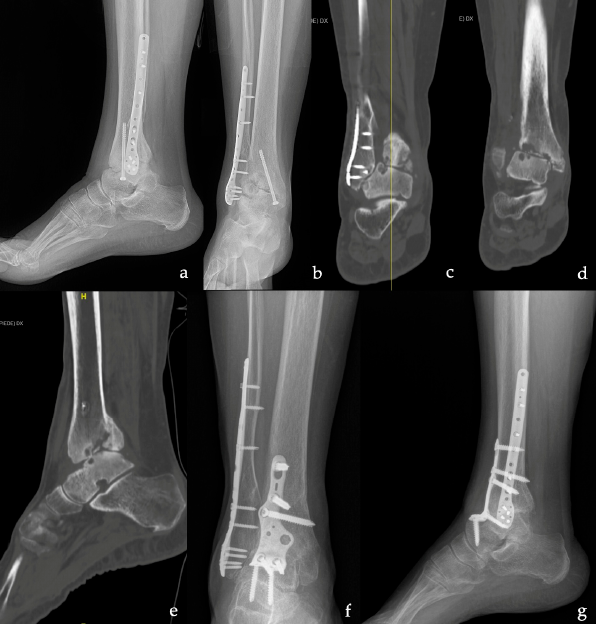
Figure 1. A 74-year-old woman with secondary post-traumatic TT osteoarthritis (OA). ( a - b ) Pre- operative X-ray in the lateral and anteroposterior view. ( c – d ) Coronal pre-operative CT scan showing severe OA of the TT joint. ( e ) Sagittal pre-operative CT scan at the level of the yellow line in figure c. ( f - g ) Anteroposterior and lateral X-ray at 6 months of follow-up from tibiotalar (TTC) arthrodesis with the anterior plate showing complete bone union.